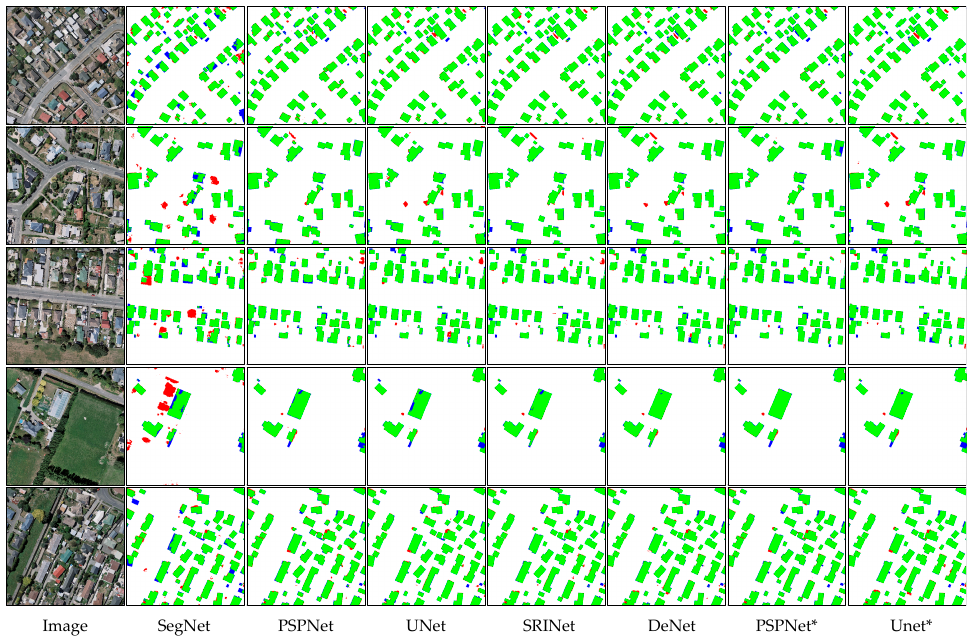
Figure 10. The building maps from the 2nd–6th columns are produced from the images in the 1st column using SegNet, PSPNet, UNet, SRINet, and DeNet. The predicted building maps of PSPNet and UNet refined with BP loss are located in the last 2 columns. * indicates that the model is refined with the proposed BP loss.